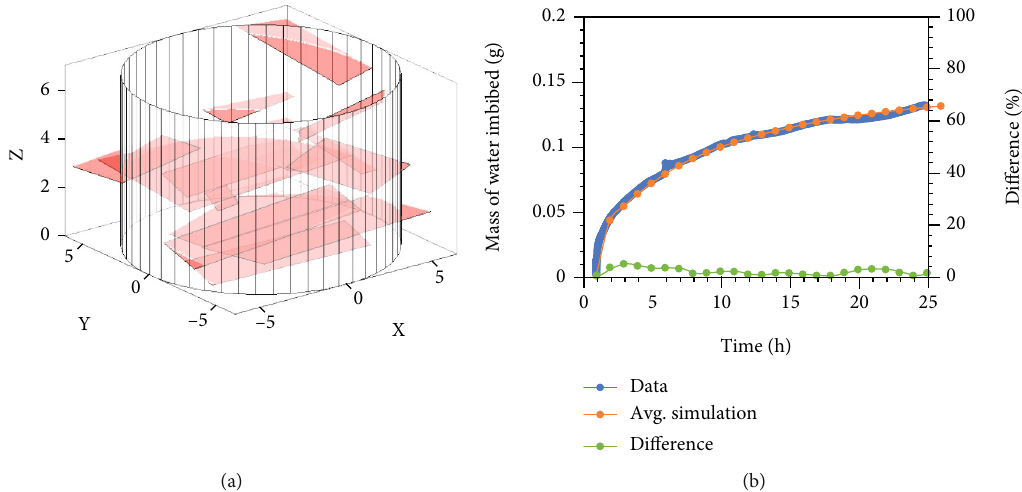
Figure 12: (a) Sketch of virtual T -direction fractures generated by the WPM model within a cylindrical Barnett sample. (b) Comparison of imbibition data vs. simulation results with T -direction